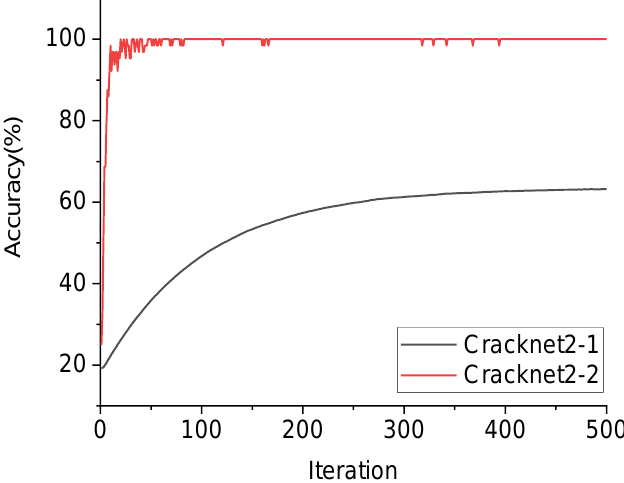
Figure 12. Accuracy variations along the training process using Cracknet2-1 and Cracknet2-2, respectively.